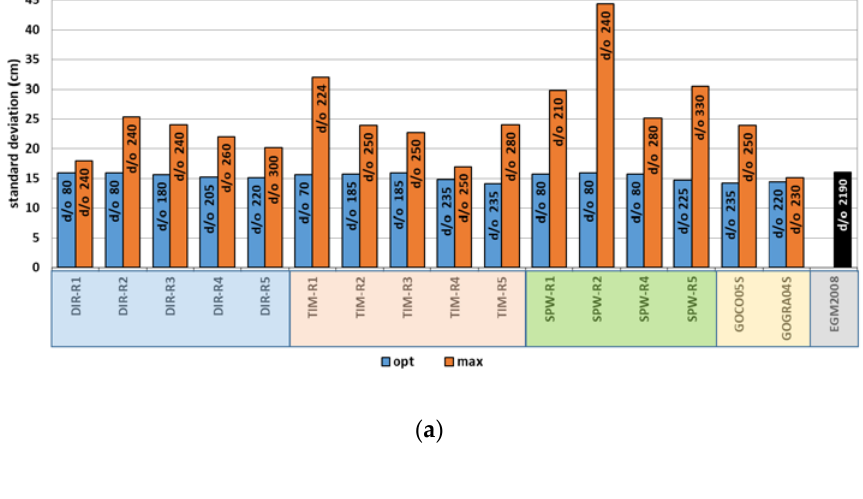
), ), GGM 𝐺𝐺𝐺𝐺𝐺𝐺𝑙𝑙𝑚𝑚ℎ . 𝑁𝑁